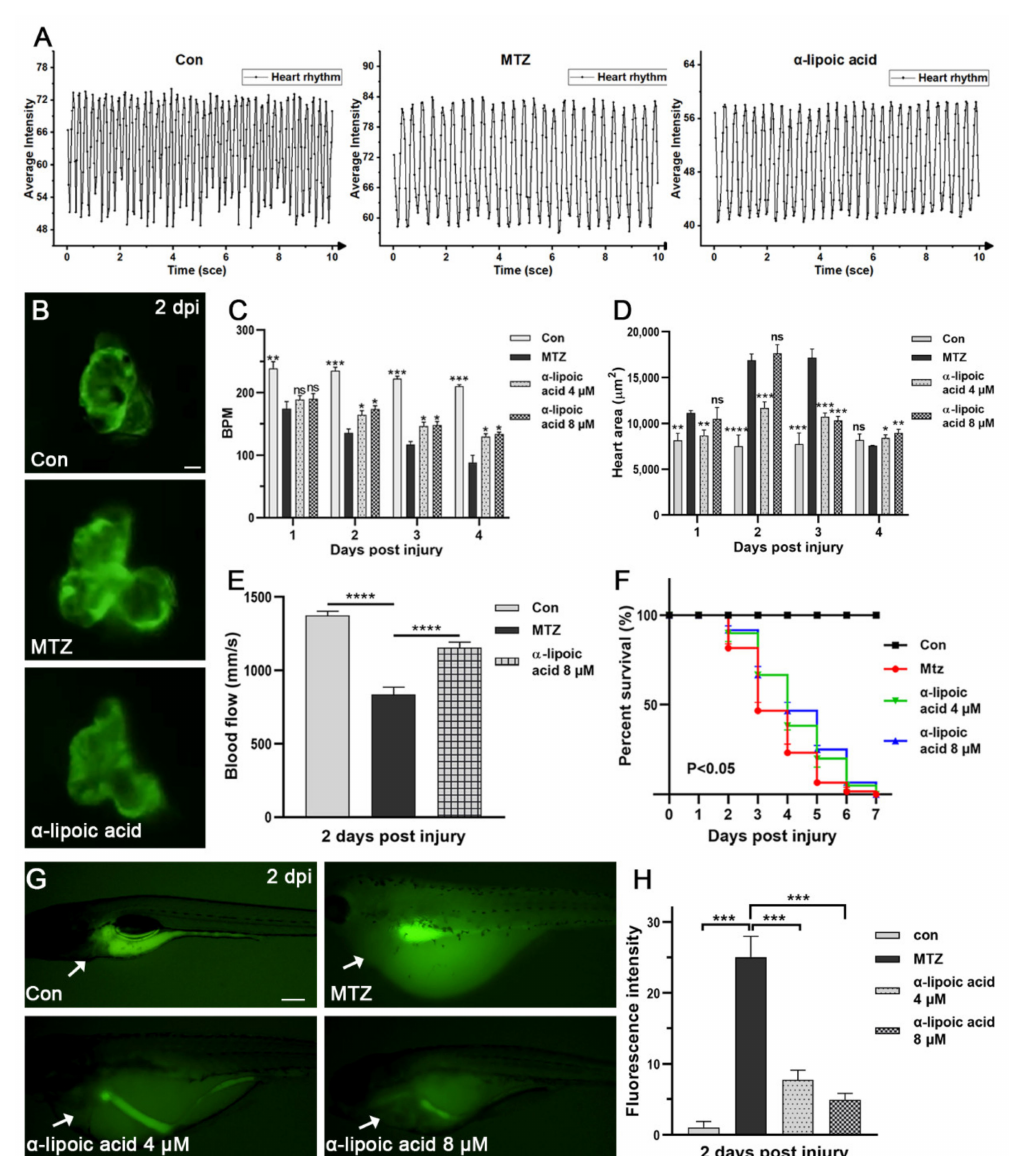
Figure 7. Effect of α -lipoic acid on CRS-3. ( A – F ) The heart rate, blood flow, heart dilatation and survival rate of ARF larvae treated with α -lipoic acid (4 µ M, 8 µ M) and the untreated group are presented. The number of larvae in each group was five, except for the survival rate group ( n = 60). Scale bar: 100 µ m. ( G , H ) MTZ-induced ROS in zebrafish larvae ( n = 5) can be attenuated by α -lipoic acid. The image shows that ROS significantly decreased as the drug concentration increased. The white arrow points to the heart area. The Scale bar of ( B , G ) are 100 µ m and 200 µ m, respectively. Mean ± SEM; ns, not significant; * p < 0.05, ** p < 0.01, *** p < 0.001, and **** p < 0.0001, ANOVA/Dunnett’s test compared with untreated ARF